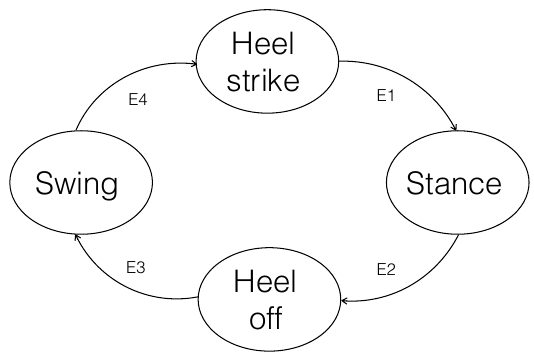
Figure 2. Gait phase detection